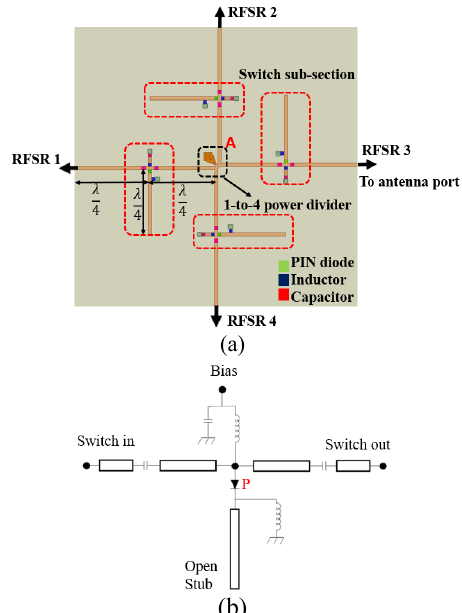
Figure 8: (a) Structure of the RFSR feeding network and (b) circuit diagram of the PIN diode switch.